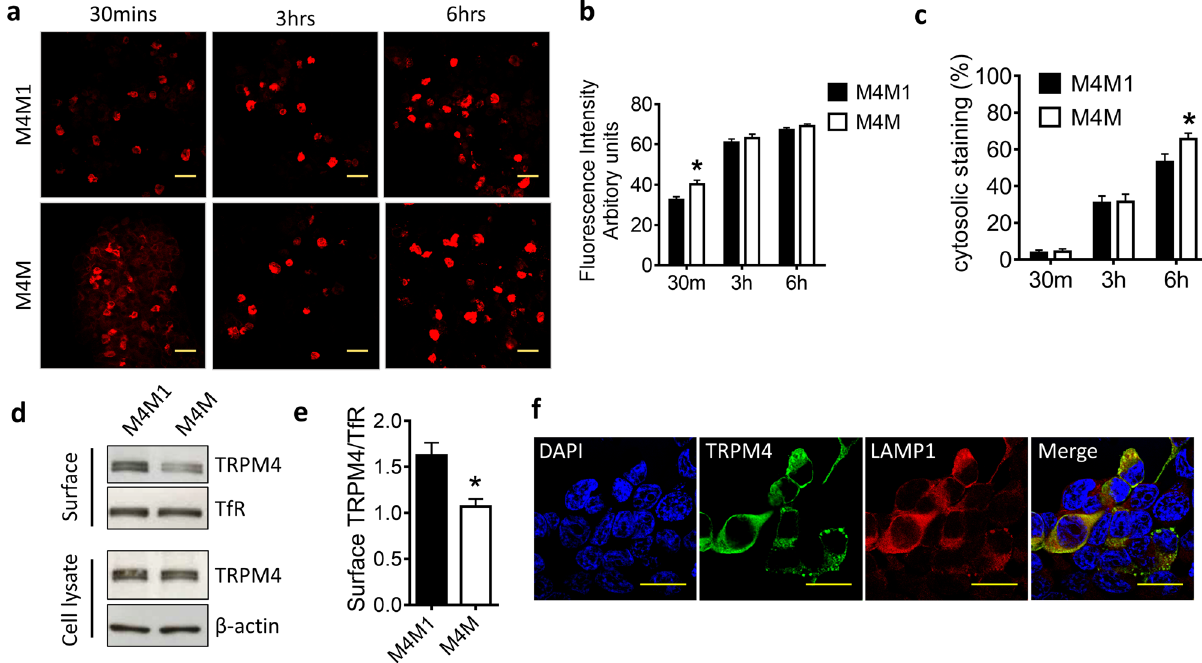
Figure 2. Detection of surface human TRPM4 using M4M and M4M1. ( a ) Live human TRPM4 expressing HEK 293 cells were incubated with M4M or M4M1 at a concentration of 0.4 µg/mL for 30 min, 3 h or 6 h, followed by fixation and staining with a secondary antibody against mouse IgG. Scale bars: 20 µm. ( b ) Summary of the fluorescent intensity. n = 4 experiments. ( c ) Summary of time dependent cytosolic staining. n = 4 experiments. ( d ) Detection of surface biotinylated human TRPM4 protein. Full-length blots are presented in Supplementary Fig. S2. ( e ) Summary of surface TRPM4 quantification. n = 4 experiments. ( f ) Colocalization of TRPM4 with lysosome marker LAMP1. Live human TRPM4 expressing HEK 293 cells were incubated with M4M for 24 h. Scale bars: 20 µm. In ( b,c ), statistical analysis was performed by two-way ANOVA with Bonferroni post-hoc analysis; in ( e ) by paired t test. *p <